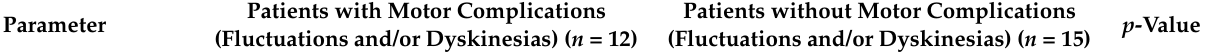
Table 5. Pharmacokinetic parameters of levodopa and 3-OMD of patients with motor complications (fluctuations and/or dyskinesias) and without motor